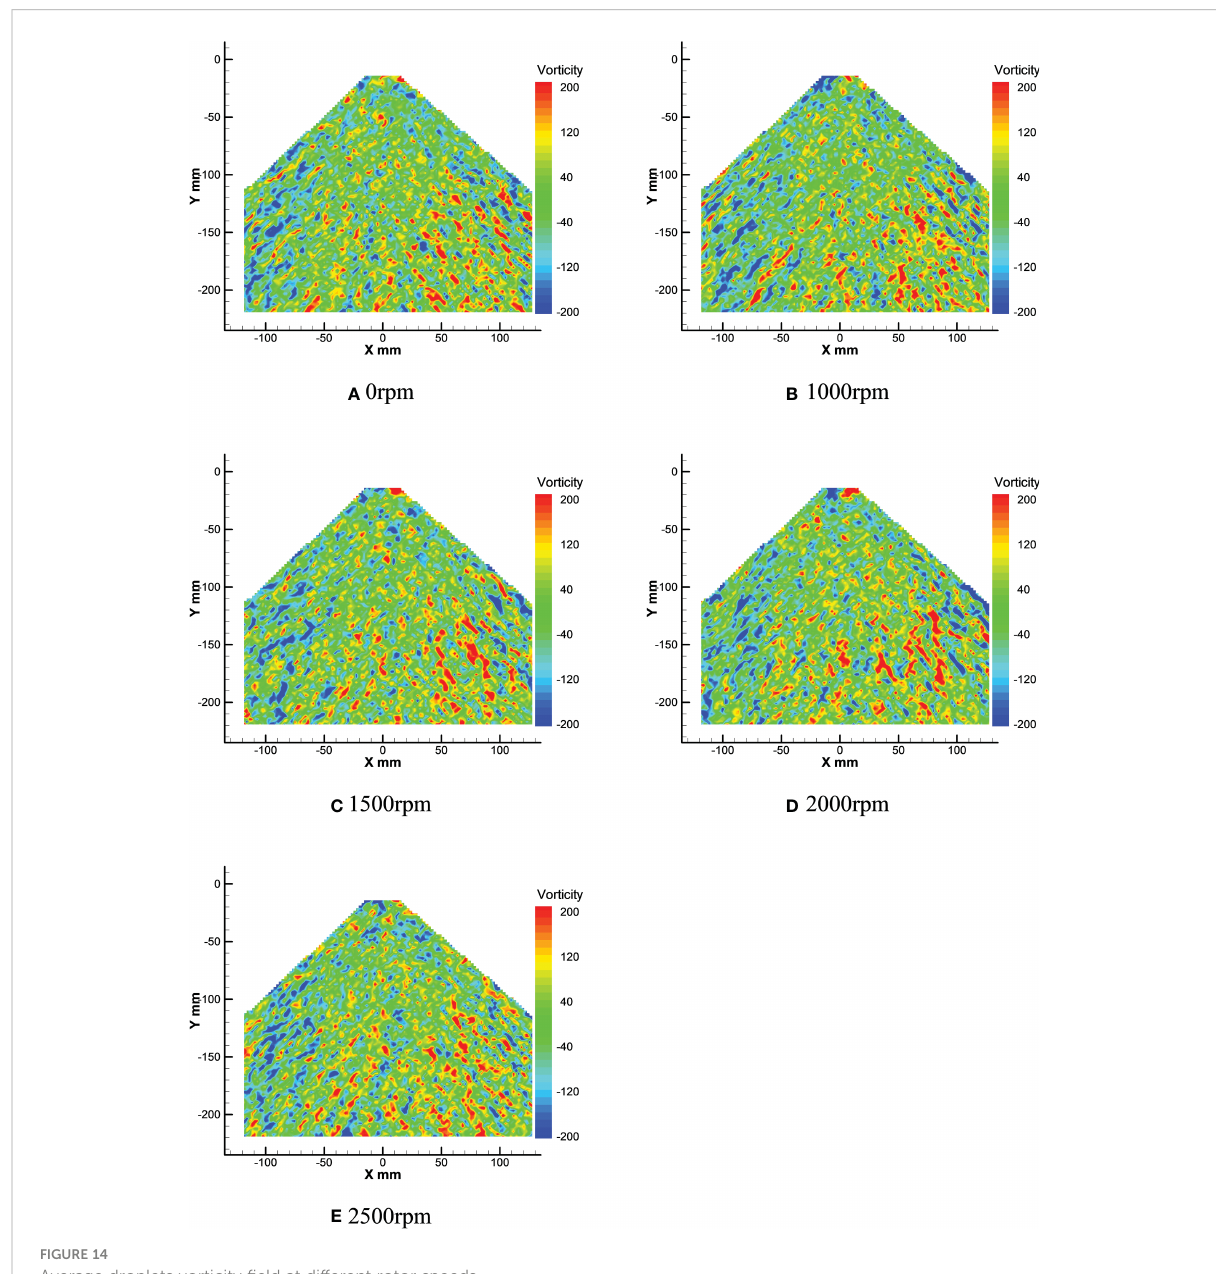
FIGURE 14 Average droplets vorticity fi eld at different rotor